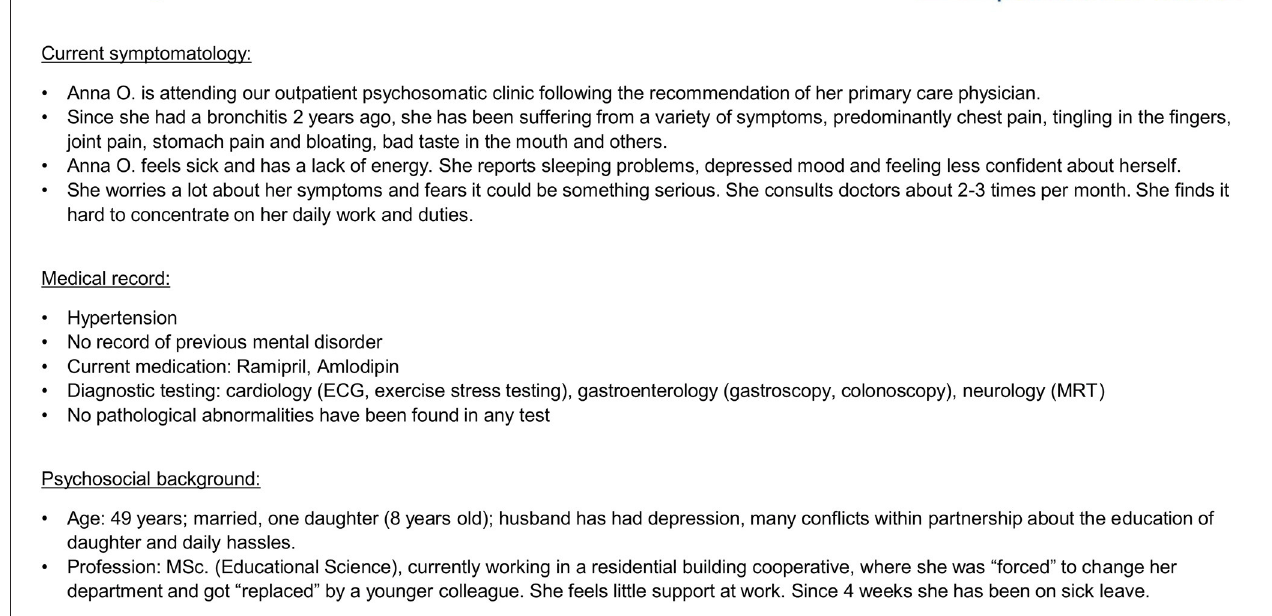
FIGURE 1 | Patient vignette of Anna O. developed according to the ICD-10 criteria of undifferentiated somatization